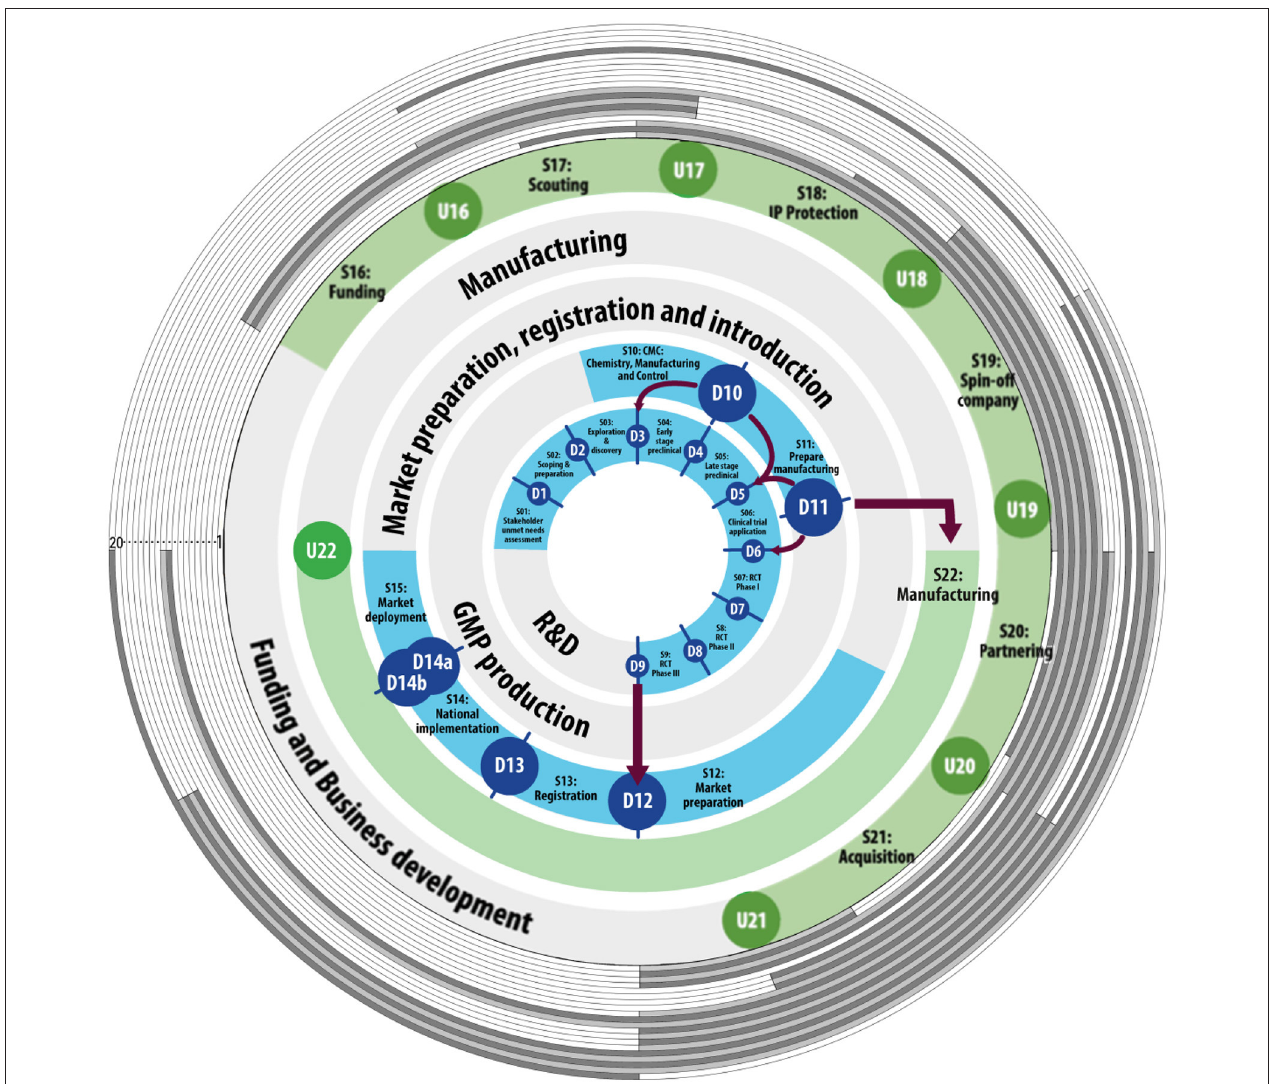
FIGURE 6 | Barriers have their impact across the vaccine innovation cycle. The inner blue and green circles represent the defined and undefined stage-gates of the Vaccine Innovation Cycle [adapted from (40)]. The monitoring stage-gates are left out for readability purposes. Numbered from 1 to 20, the gray colored circles each represent one of the 20 identified key barriers. Where the circle is shaded, the barrier impacts the corresponding stage in vaccine